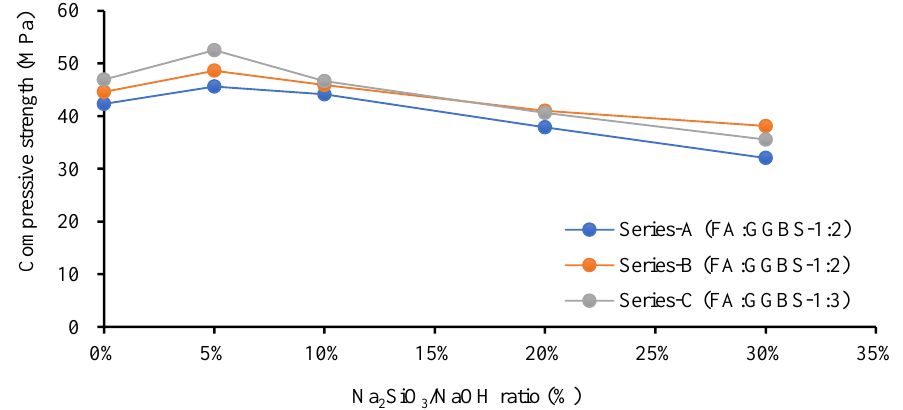
Figure 12. Compressive strength test results for the geopolymer specimen using various Na 2 SiO 3 -to-NaOH and FA-to-GGBS ratios with sand preheated at 110 °C and cured in a hot oven at a uniform temperature of 50 °C for 3 h.